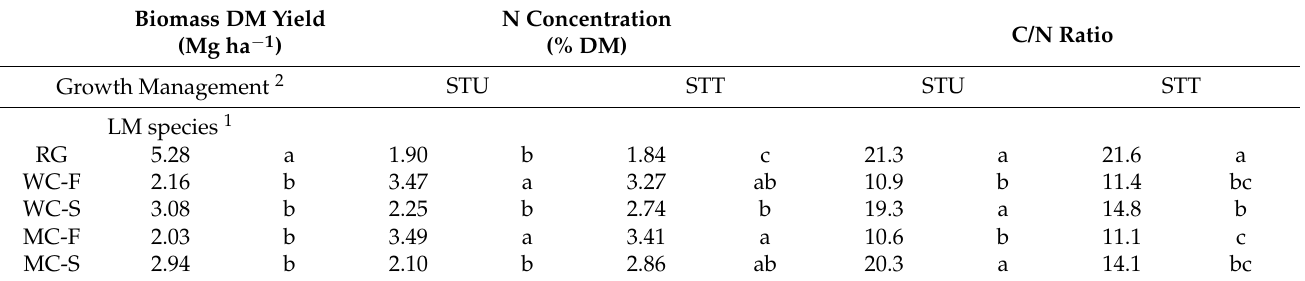
Table 7. Yield, N concentration and C/N ratio of the living mulch aboveground biomass shortly before the cabbage harvest at the location UH. Values with at least one identical letter indicate non-significant differences among growth management treatments (capital letters) or LM treatments (lowercase letters) at α = 0.05.